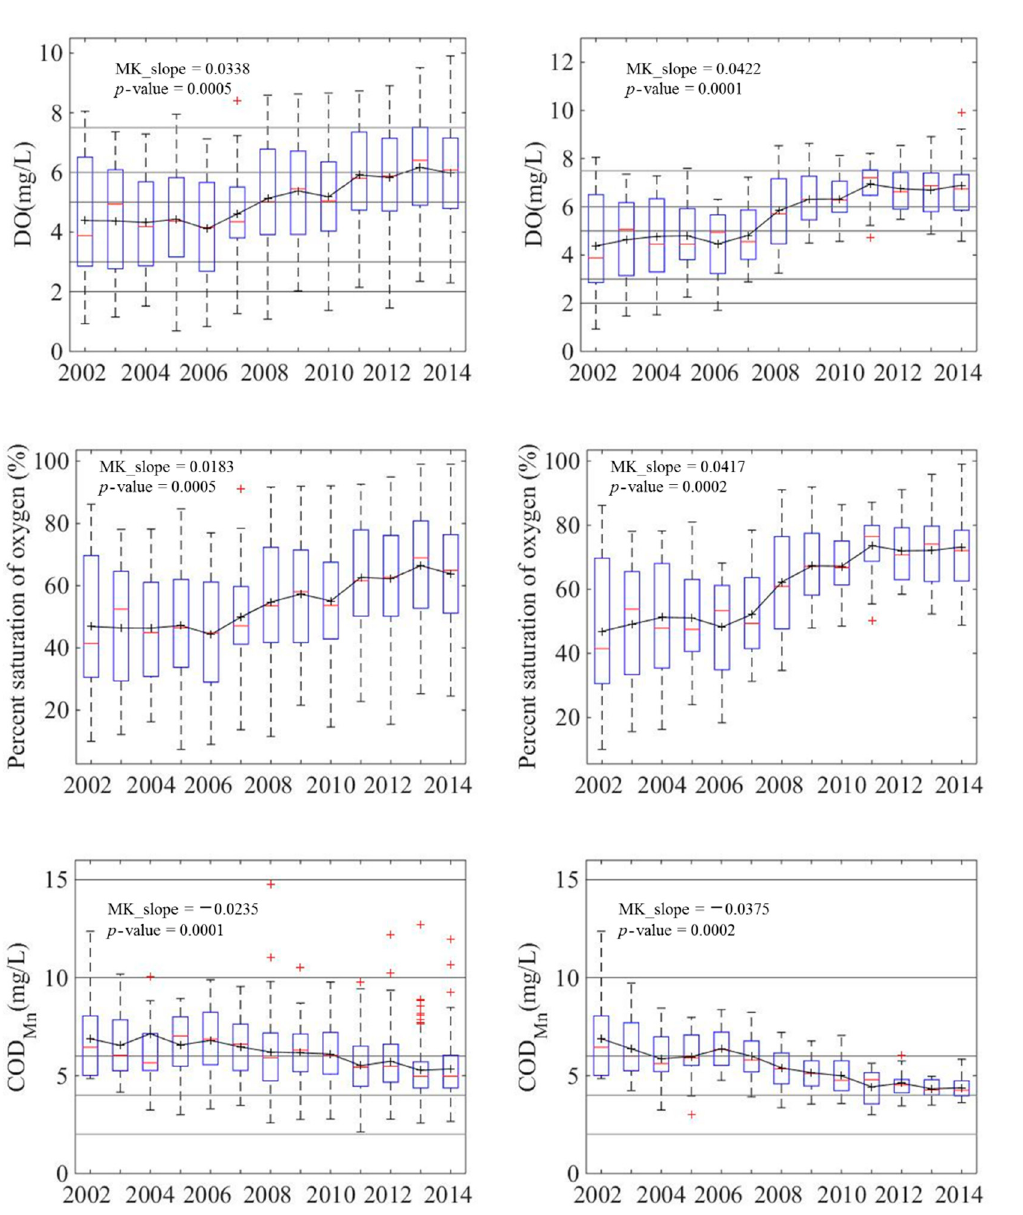
Figure 2. Variations in the mean values and boxplots of the annual average DO concentration, percent saturation of oxygen and COD Mn concentration from 2002 to 2014 based on different levels of the GB3838-2002 standards (the lines of the Class V standard to the Class I standard gradually change from black to 50% gray; the curves represent the mean values, the black ‘+’ symbols represent the mean values of the data, the red lines represent the median values of the data, the edges of the boxes are the 25th and 75th percentiles, the whiskers extend to the most extreme data points that were not considered outliers by the algorithm, and the outliers are plotted individually as red ‘+’ symbols; the boxplots in the left column are based on all sites, and the plots in the right column are based on 16 sites). The trends of mean values are estimated using the MK test, as shown as the texts of MK_slope and p _value in all sub